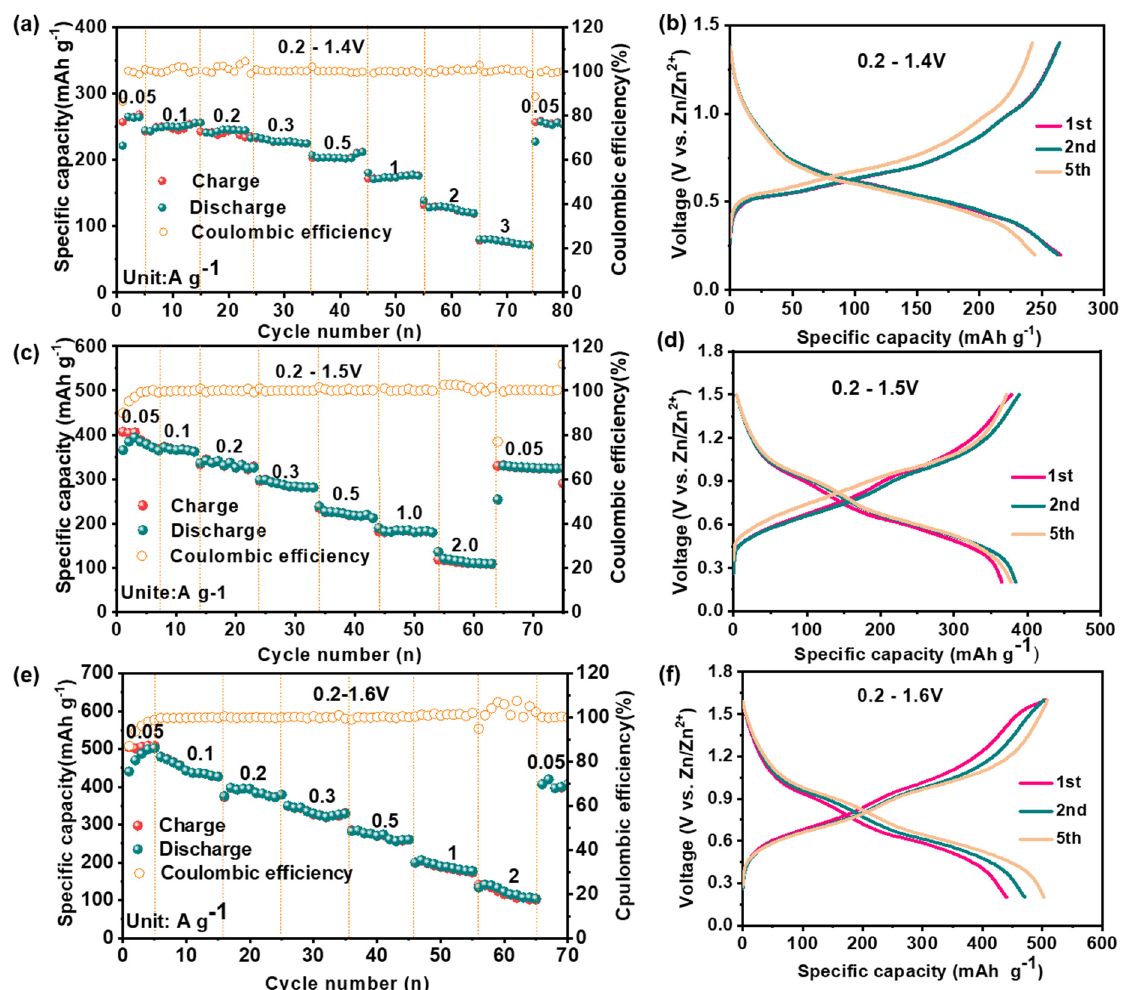
Figure 4. The electrochemical performance of PO-VO 2 //Zn batteries: ( a , b ) the rate performance at different current densities and corresponding galvanostatic charge-discharge curves in the voltage of 0.2–1.4 V; ( c , d ) the rate performance at different current densities and corresponding galvanostatic charge-discharge curves in the voltage of 0.2–1.5 V; ( e , f ) the rate performance at different current densities and corresponding galvanostatic charge-discharge curves in the voltage of 0.2–1.6 V.